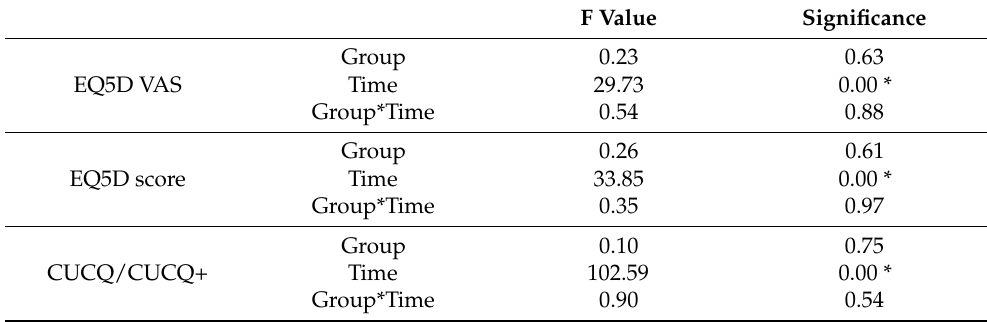
F Value Significance